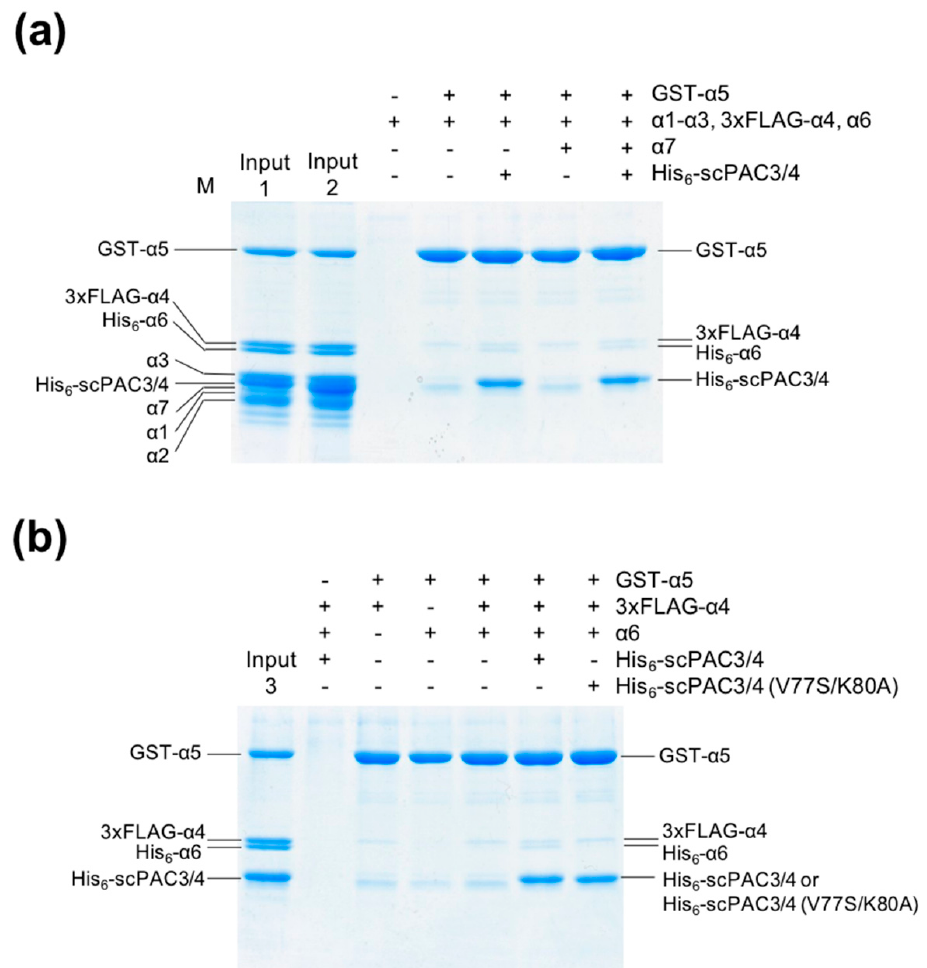
Figure 2. Pull-down experiments between α 5 and the other α subunits. The α 1– α 4, α 6, and α 7 subunits were mixed with GST-tagged α 5 immobilized on Glutathione Sepharose beads. The 3xFLAG-tagged α 4 and His 6 -tagged α 6 were used to avoid the overlap of their bands with those of the other α subunits or scPAC3/4. ( a ) Interactions between α 5 and the other α subunits in the presence and absence of the PAC3-PAC4 heterodimer. The ‘Input1 ′ and ‘Input2 ′ lanes contained His 6 -scPAC3/4 and α 1– α 6 subunits in the absence and presence of α 7, respectively (0.5 μ g each). ( b ) Interaction between α 5 and the adjacent α subunits, α 4 and α 6. The ‘Input3 ′ lane contained His 6 -scPAC3/4 and α 4– α 6 subunits. The pull-down experiment was also performed using an scPAC3/4 mutant with V77S and K80A substitutions in PAC3. Band assignments were carried out according to Figure S1b.